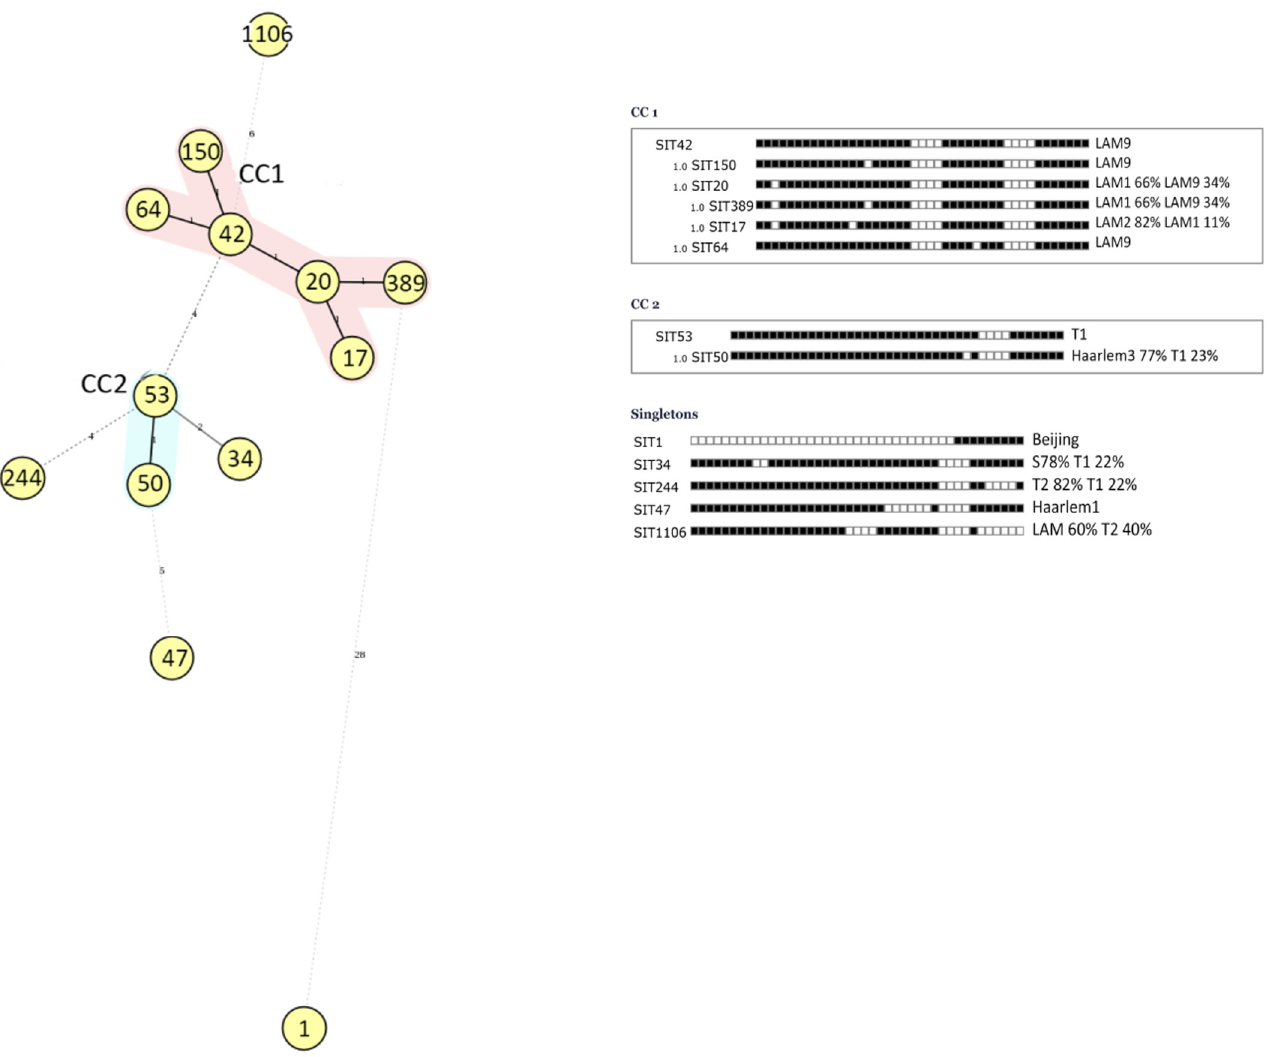
Fig 1. The bank of cages assignment for the thermally cooled perch treatment. Each tier had its own pump to distribute chilled deionized water (10°C) through its perch loop that ran parallel to the feeder. The front perch closest to the feeder received chilled water pumped directly from a common vertical manifold. The back perch was the return loop that sent the water back to the common manifold to be re-chilled. A chiller was used to cool the water in the manifold; it had its own independent thermostat which kept the water at 10°C. A separate 4th pump continuously circulated the deionized water between the water chiller and the manifold. A sensor for monitoring air temperature was installed to the controller of each tier to activate or stop the circulation of chilled water through the perch loop when ambient temperature reached or fell below 25°C, respectively